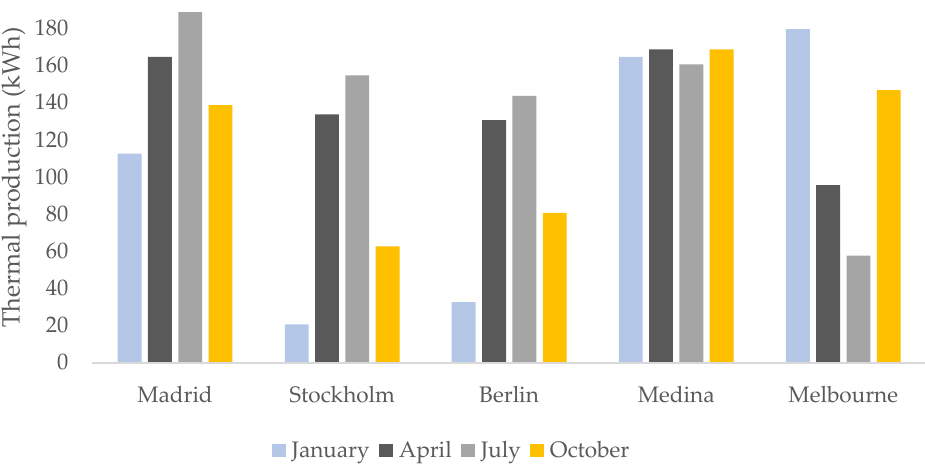
Figure 12. Collector monthly thermal production variation.